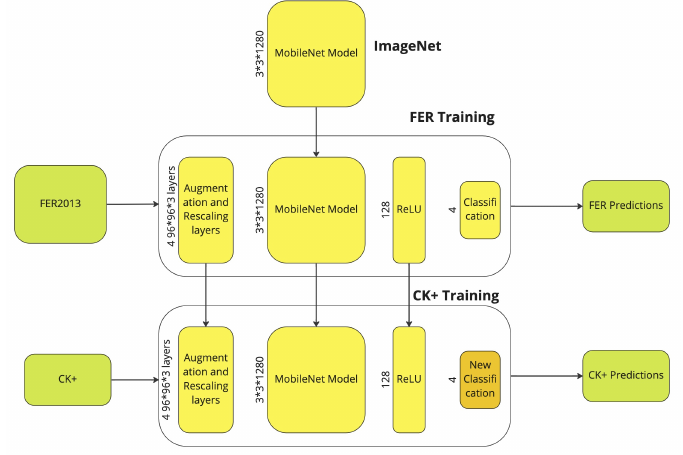
Figure 4. Architecture of deep facial emotion recognition model. For each task, the model is trained with frozen weights with new head first and then fine-tuned.